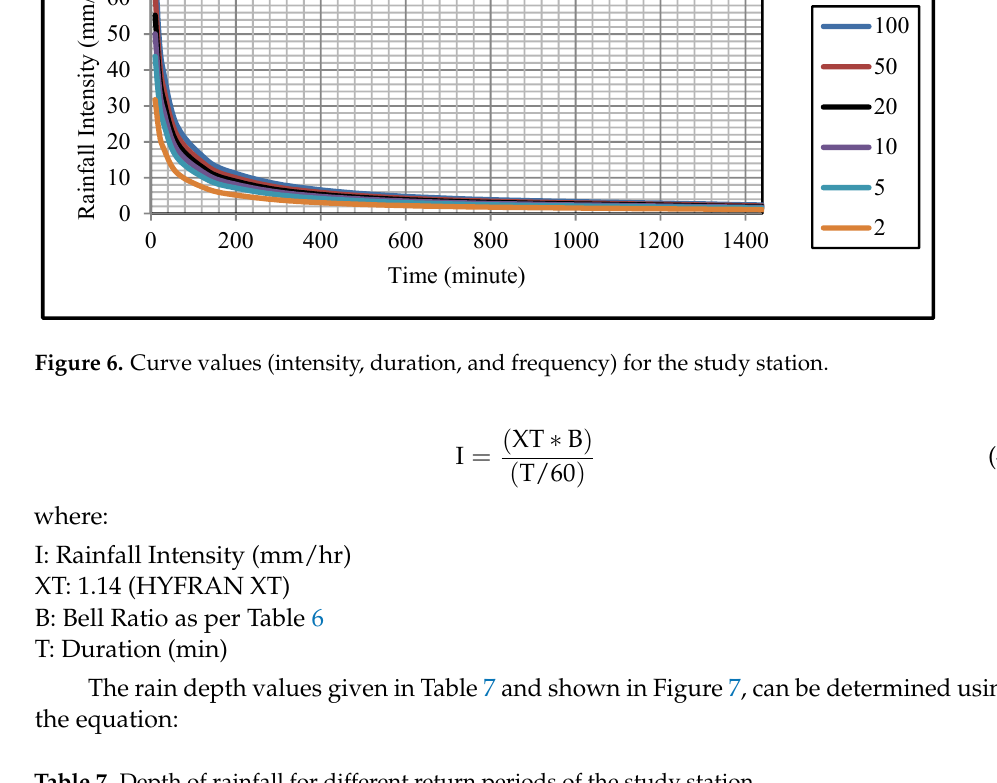
Table 7. Depth of rainfall for different return periods of the study station.